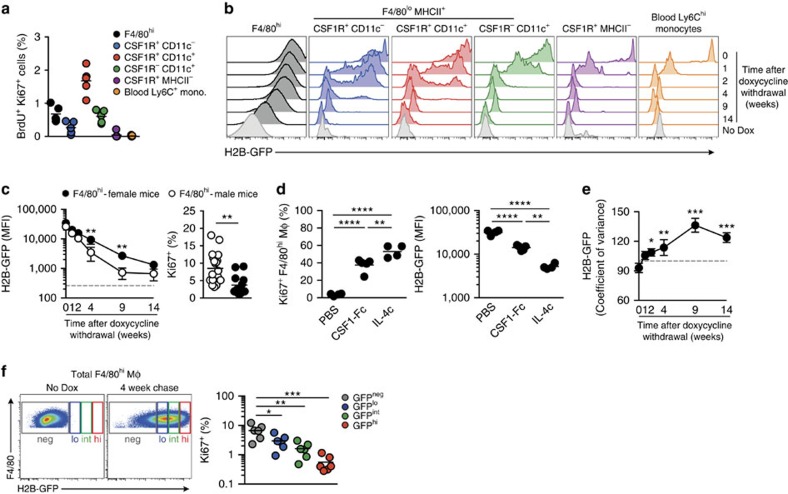
Heterogeneity in proliferative activity of F4/80hi macrophages.(a) Frequency of BrdU+Ki67+ cells amongst peritoneal F4/80hi macrophages, Ly6C+ monocytes and CD11c/CSF1R-defined F4/80loMHCII+ subsets, and Ly6C+ blood monocytes from 8-week old female WT mice administered 1 mg BrdU s.c. 2 h before necropsy. Data are from one of two independent experiments with 5 mice per group. (b-f) H2B-GFP mice were administered doxycycline diet for 2 weeks before the expression of H2B-GFP by PEC subsets was assessed by flow cytometry. (b) Expression of H2B-GFP fusion protein by peritoneal F4/80hi macrophages, Ly6C+ monocytes and CD11c/CSF1R-defined F4/80lo MHCII+ subsets, and Ly6C+ blood monocytes from H2B-GFP mice 0, 1, 2, 4, 9 and 14 weeks following the cessation of doxycycline administration. Data are from one experiment of two performed with 3 (0, 1, 2, 4 and 9 weeks) or 4 (14 weeks) mice per time point. Light grey histograms represent the background fluorescence of each cell population obtained from mice that did not receive doxycycline (‘No Dox'). (c) Mean fluorescence intensity (MFI) of H2B-GFP expression (left) and Ki67 expression by F4/80hi macrophages from the female (solid circles) and male (open circles) H2B-GFP mice as in b. One-way ANOVA followed by Tukey's multiple comparison test (H2B-GFP MFI) and upaired Student's t-test (Ki67; **P<0.01). (d) Expression of Ki67 (left) and MFI of H2B-GFP expression (right) by PEC F4/80hi macrophages from mice administered CSF1-Fc, IL-4c or vehicle control at day 1 and day 3 post-cessation of doxycycline and analysed 1 day later. Data from one of two independent experiments with 4 (PBS, IL-4c) or 5 (CSF1-Fc) mice. One-way ANOVA followed by Tukey's multiple comparison test. **P<0.01, ****P<0.0001. (e) Co-efficient of variance of H2B-GFP expression by F4/80hi macrophages from the peritoneum of mice in b. One-way ANOVA followed by Tukey's multiple comparison test. *P<0.05, **P<0.01, ***P<0.001. (f) Gating strategy used to define GFPhi, GFPint, GFPlo and GFP– F4/80hi macrophages from H2B-GFP mice administered doxycycline diet for 2 weeks and ‘chased' for 4 weeks (left) and expression of Ki67 by the GFP-defined fractions of, F4/80hi macrophages. One-way ANOVA followed by Tukey's multiple comparison test. *P<0.05, **P<0.01, ***P<0.001. Each symbol represents an individual animal and horizontal bar is the mean. Data represent 6 mice and are pooled from two independent experiments.